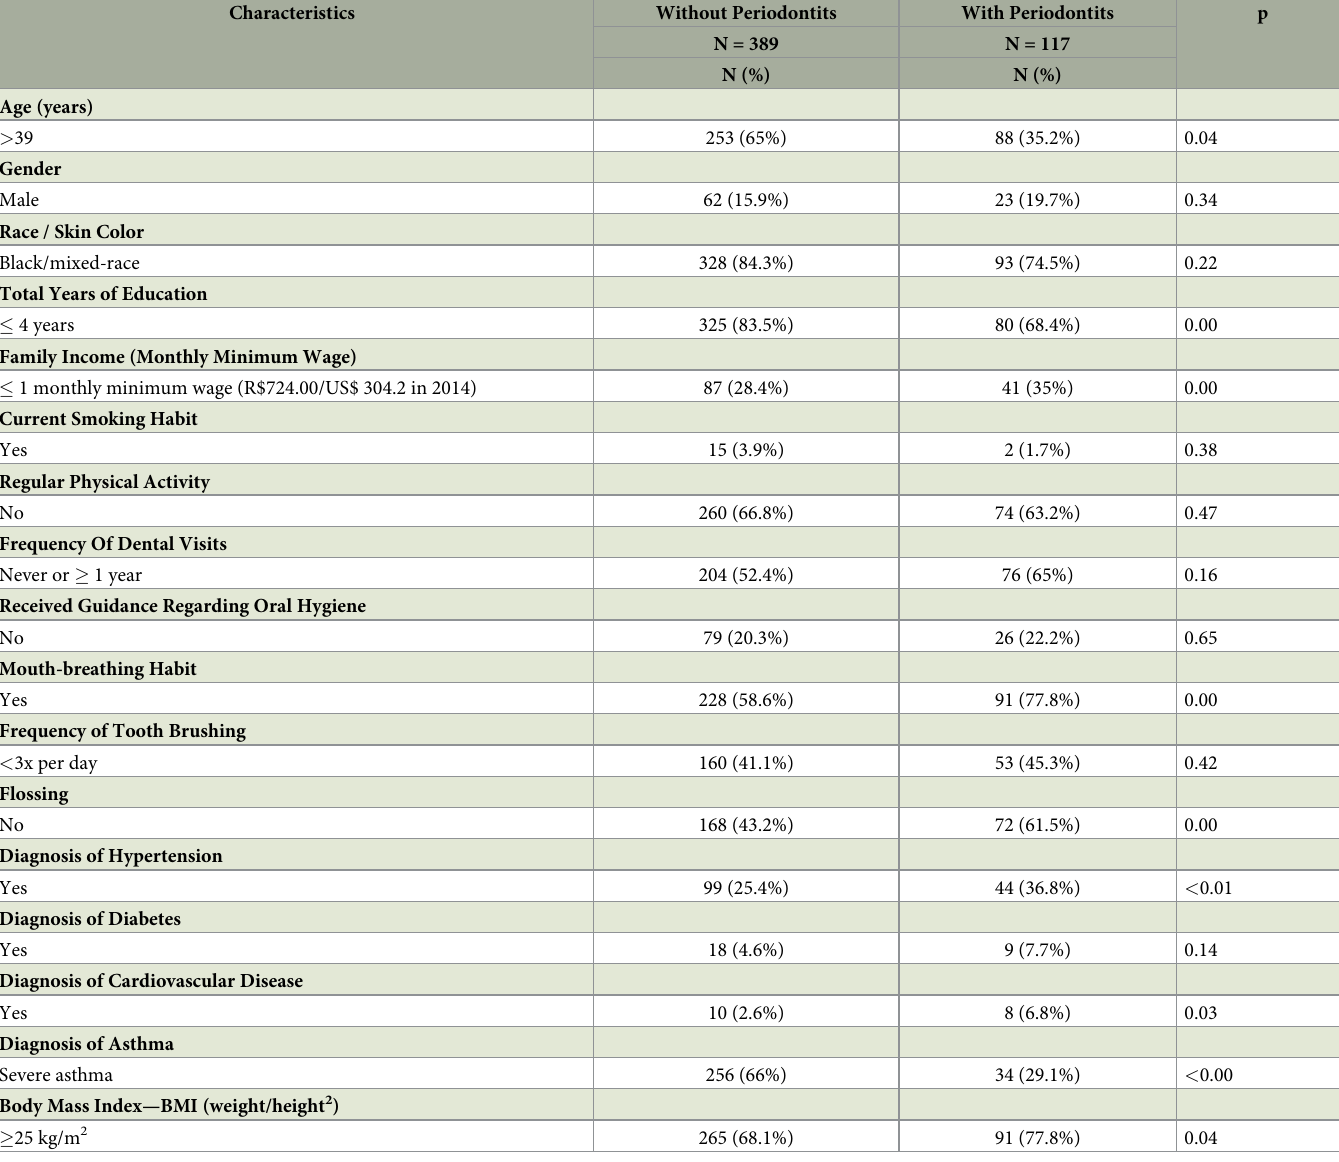
Table 1. Distribution of socioeconomic-demographic characteristics of the sample according to the presence of periodontitis, related to lifestyle, general health, and oral health. Characteristics Without Periodontits With